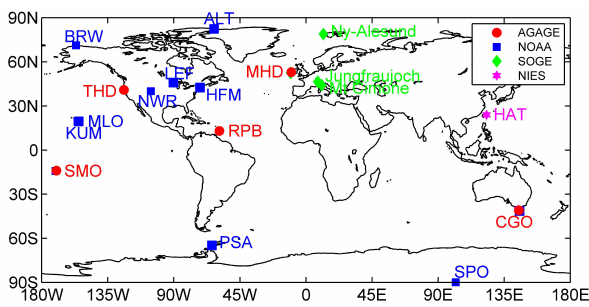
Fig. 1. Location of CH 3 Cl observing sites from different surface